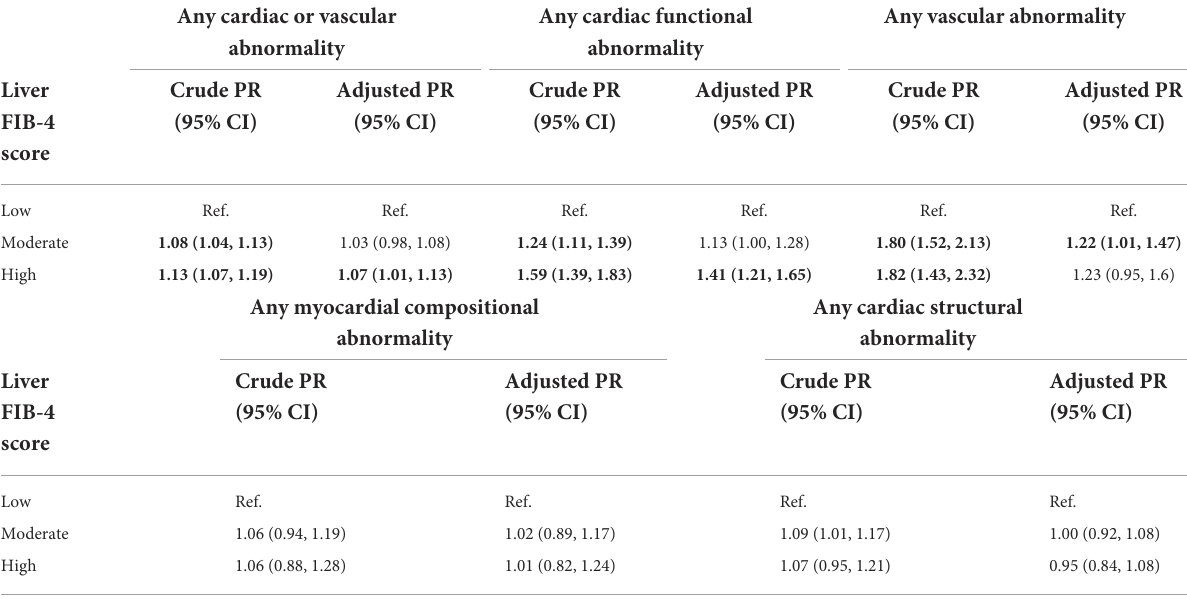
TABLE 3 Multivariable-adjusted prevalence ratio of cardiovascular abnormalities in association with hepatic fibrosis * .